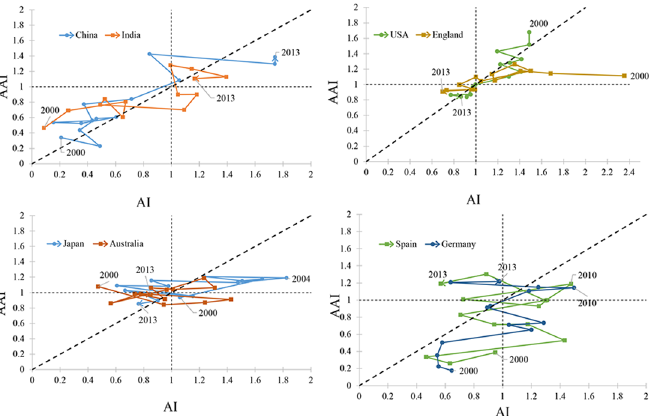
Fig 5. Relational chart of AI and AAI from 2000 to 2013 for 8 countries/regions, China, India, the U.S., England, Japan, Australia, Spain, and Germany. The reference line x = y represents the balanced status of AI and AAI of a country/reigon’s natural diaster